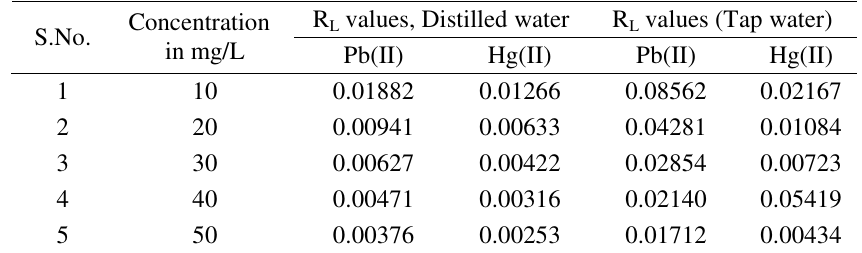
Figure 8 . Langmuir adsorption isotherm for Hg(II). Table 2 . R